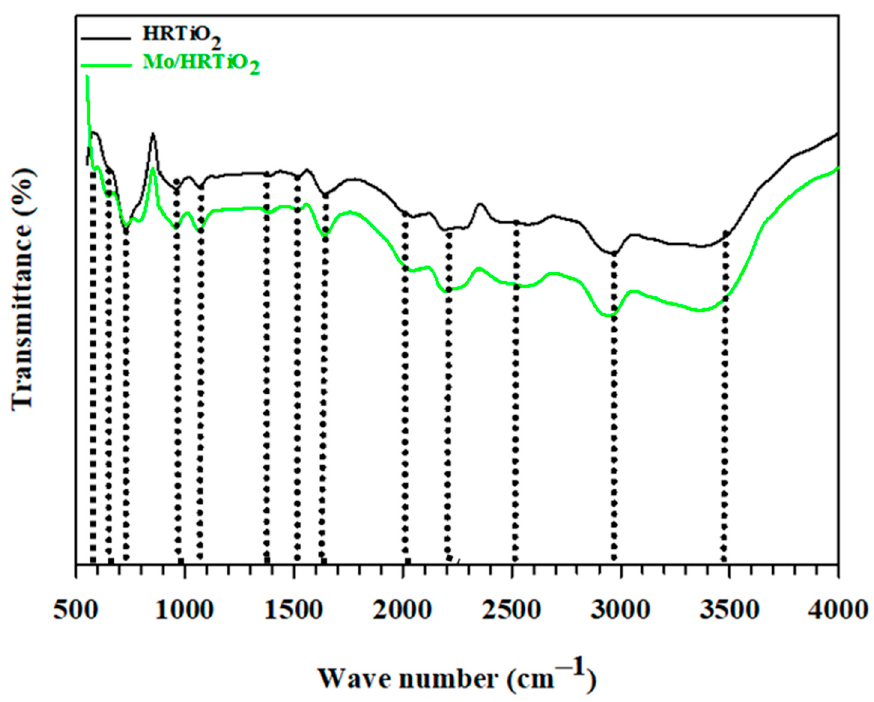
Figure 3. FTIR measurement for the unmodified HRTiO 2 (black line) and modified Mo/HRTiO 2 (green line).